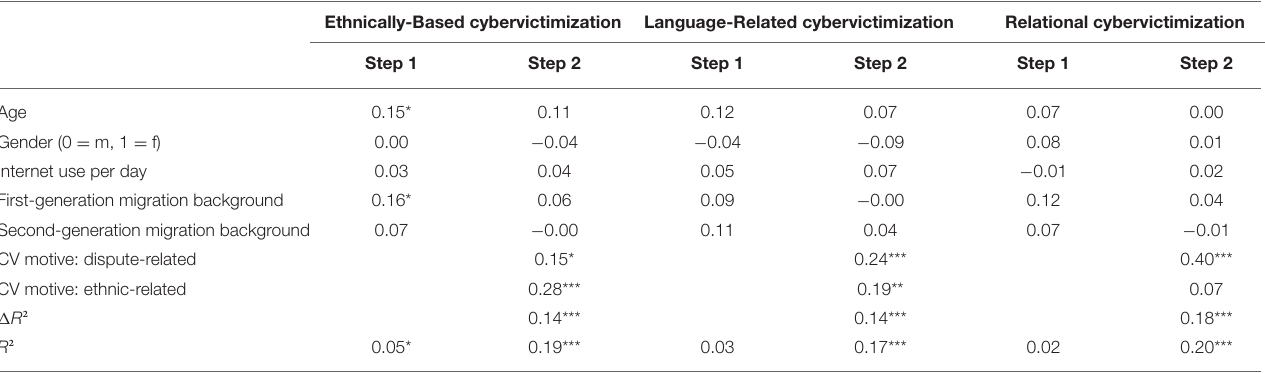
TABLE 3 | Hierarchical regression analysis concerning forms of